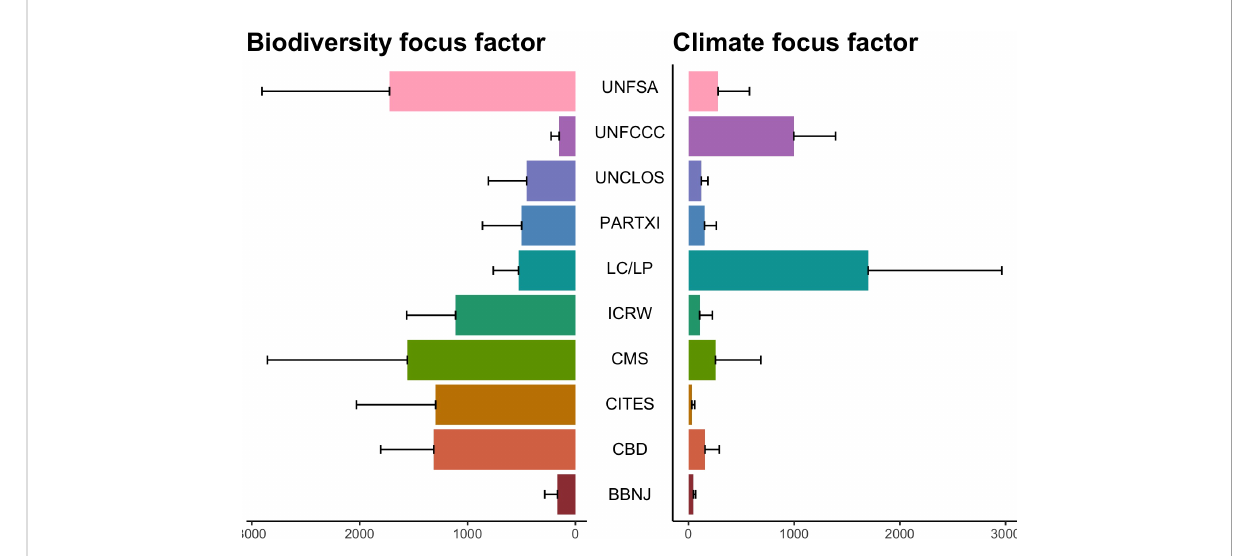
FIGURE 2 The biodiversity and climate focus factors of international agreements (in alphabetical order). The focus factor derives from text mining the policies and their implementing documents for keywords and text sections discussing biodiversity and climate. It is calculated from the frequency and diversity of climate and species keywords in the documents (Eq. 1). High values of focus factors imply high integration of biodiversity and climate topics, respectively. Abbreviations of agreements are listed in Table